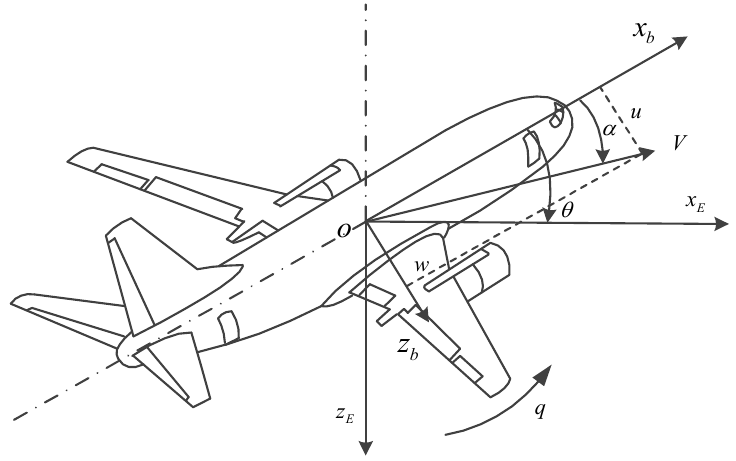
Figure 1. Coordinate systems of longitudinal motion of aircraft.